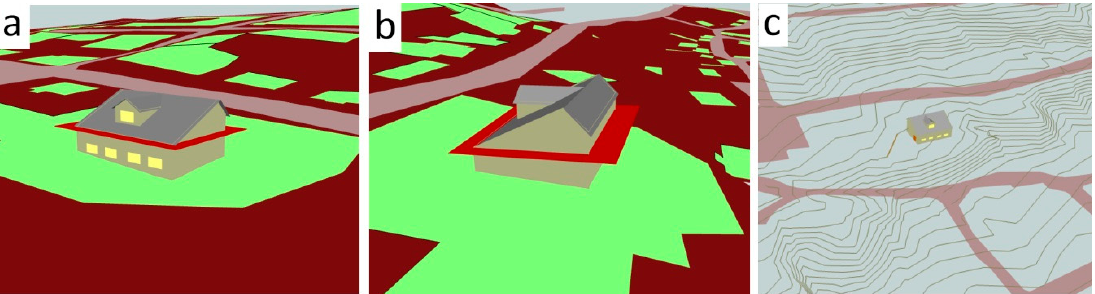
Figure 4. The tested building placed in the same location in a detailed planning map but with different orientation ( a , b ). Green areas are areas where one is allowed to build, brown areas do not allow building, grey are roads and the red horizontal plane crossing the building is the maximum building height. ( c ) Contour lines with 1 m contour interval are included to give an overview of the topography in the area.